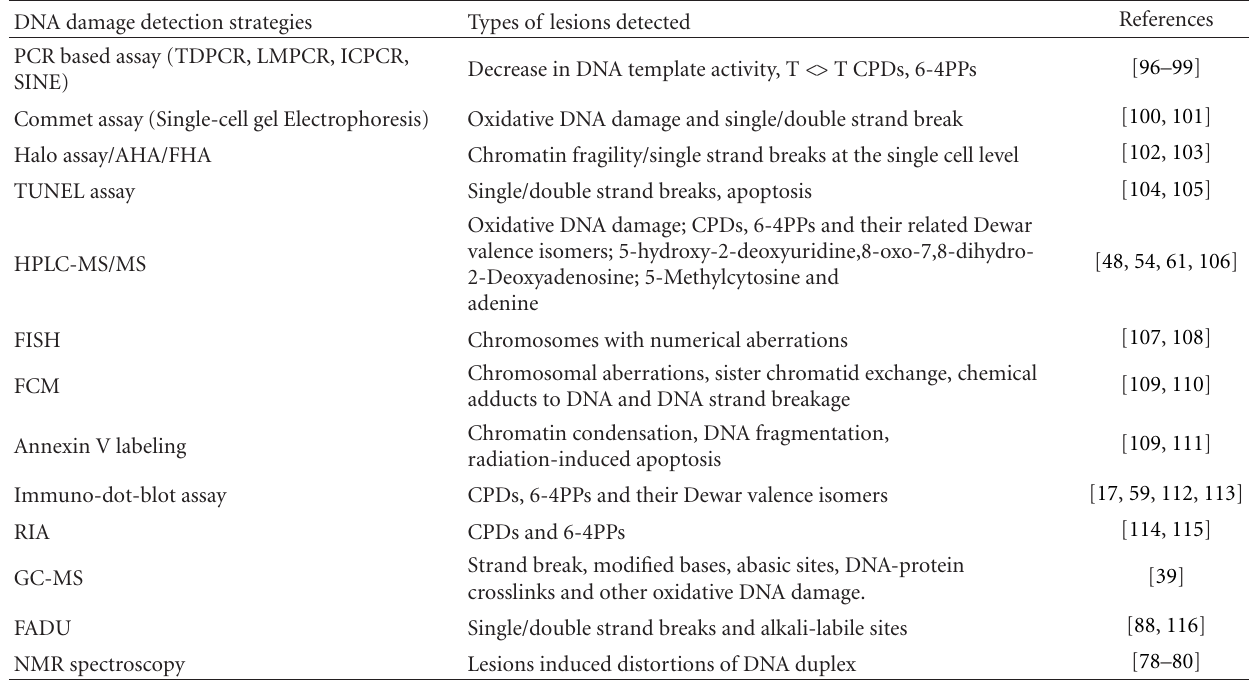
Table 1: Various strategies for the detection of damaged